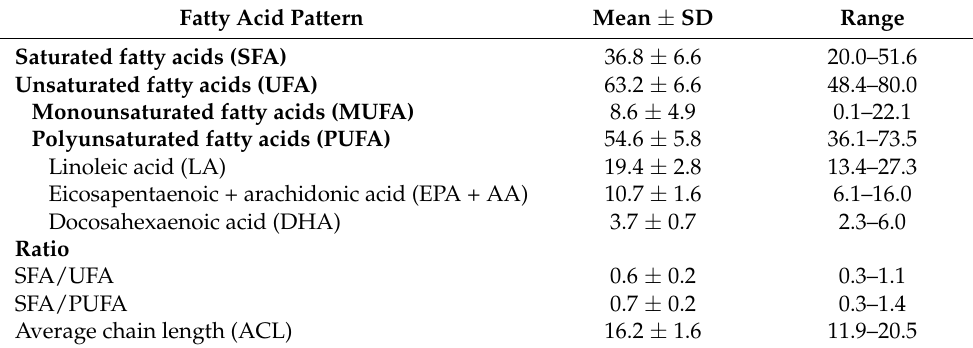
Table 3. Fatty acid profile of esterified HDL lipids in the total healthy population.